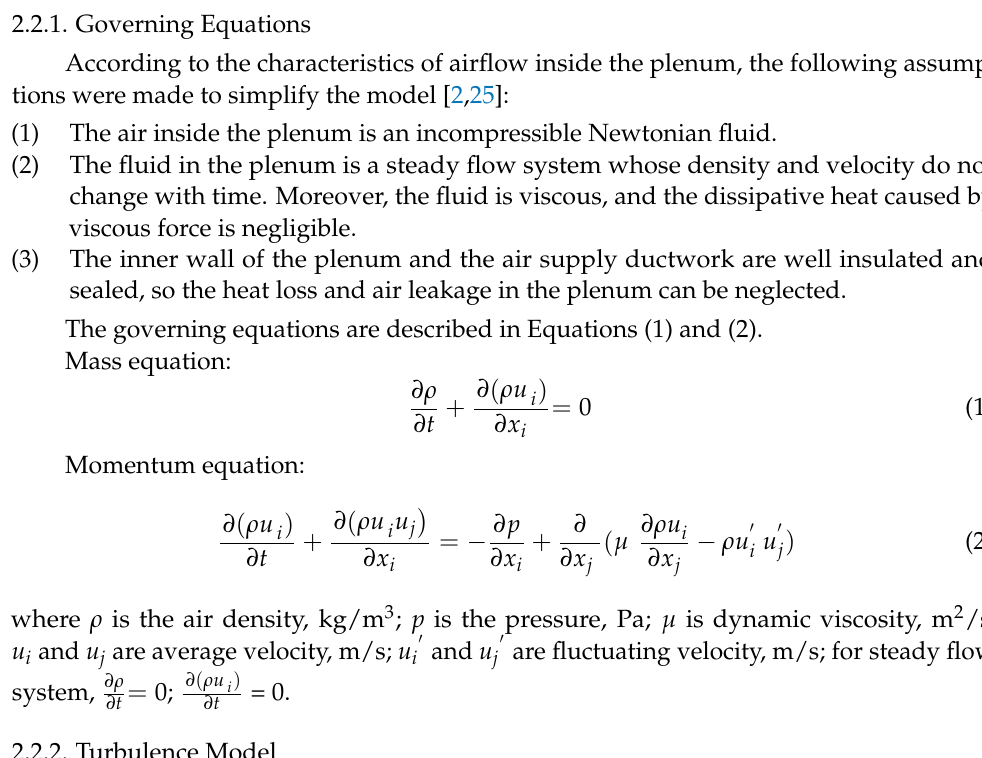
Figure 3. Physical model of the plenum and diffusers.